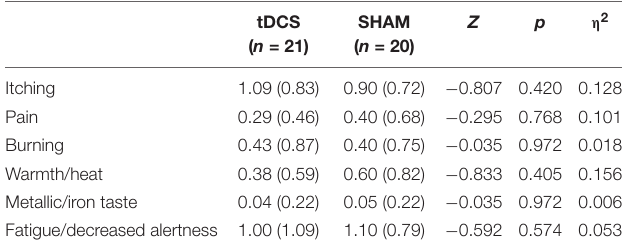
TABLE 2 | Group comparisons on intensity of perceived sensations from the Questionnaire of sensations related to transcranial electrical stimulation (Antal et al., 2017).